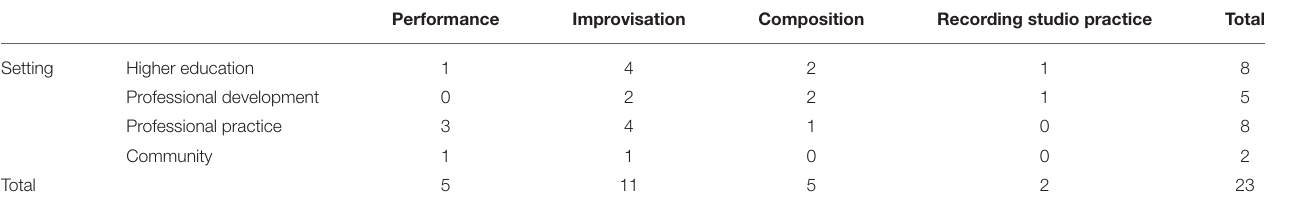
TABLE 5 | Settings for the